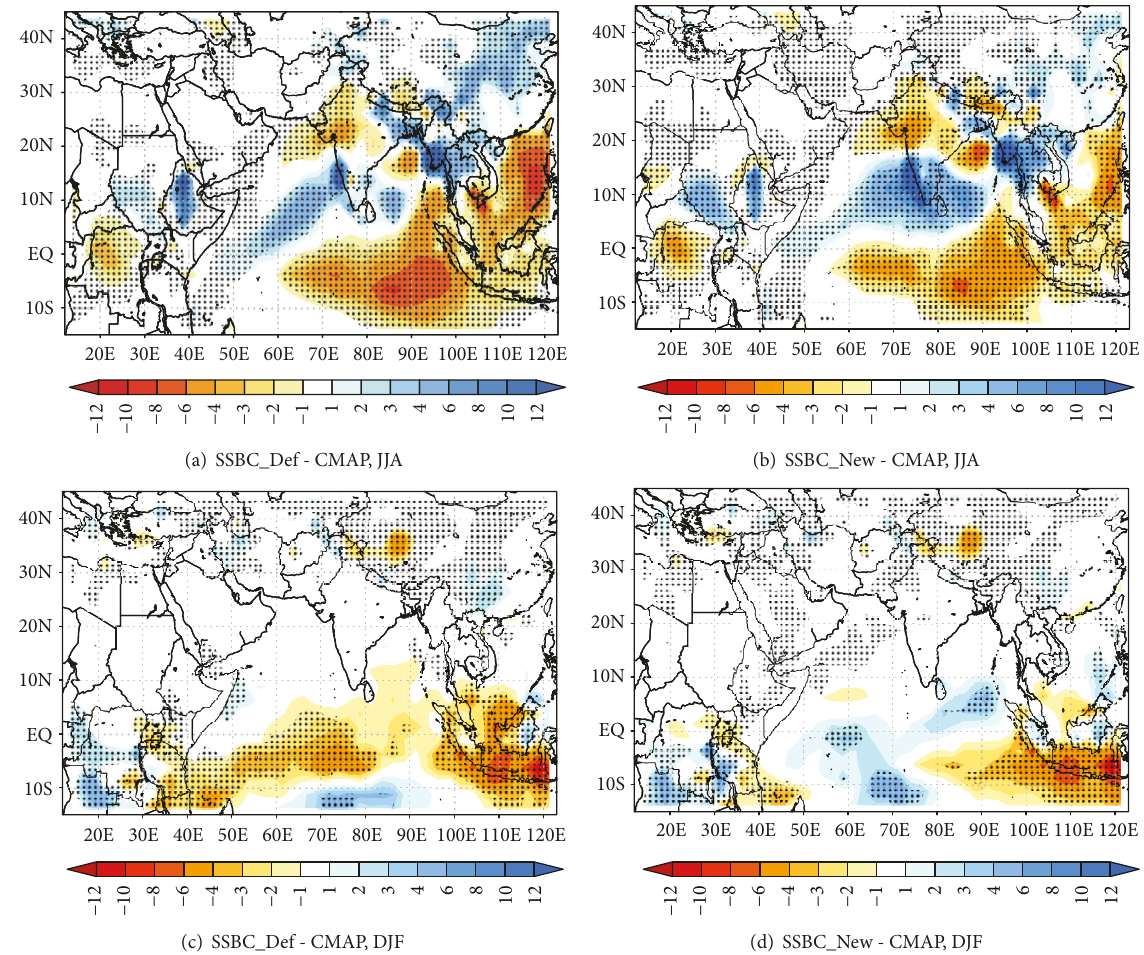
Figure 5: The same as Figure 4 but for the difference of surface precipitation (mmd −1 ) of SSBC_Def (b and e) and SSBC_New (c and f) bias relative to CMAP (a and b) observations. The blue and red colors indicate the wet and dry bias of surface precipitation (mmd −1 ) over the statistically significant regions (shaded as black dots) at 99% confidence